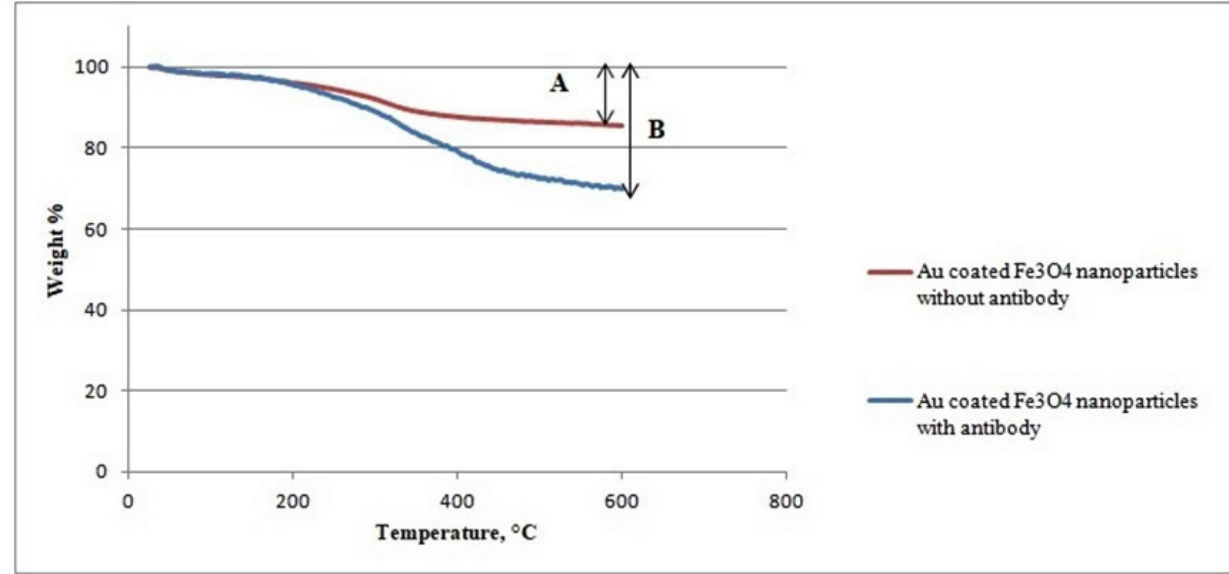
O nanoparticles with and without antibody. A is mass loss of gold 3 4 +W ) - W , B is mass loss of antibody conjugated gold coated citrate NP citrate +W +W ) - (W +W citrate NP AB citrate AB